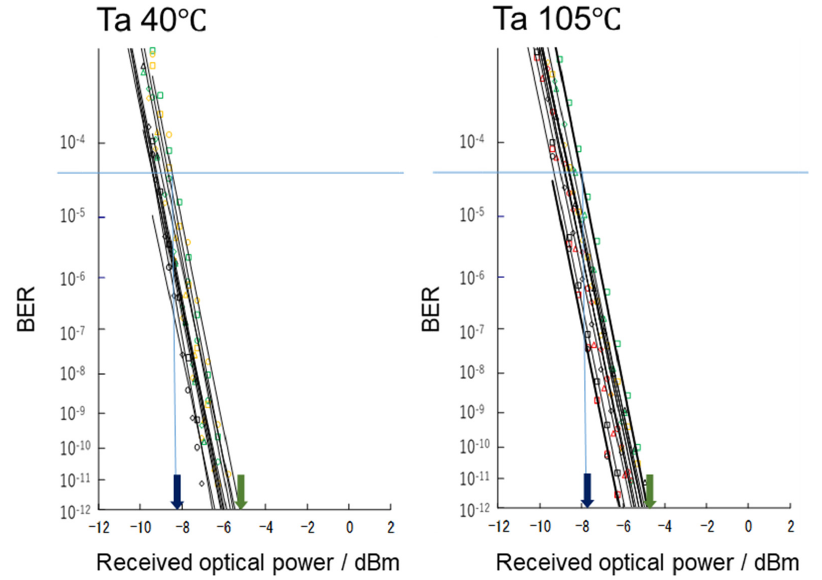
Figure 14. Optical bit error rate vs. received optical power .